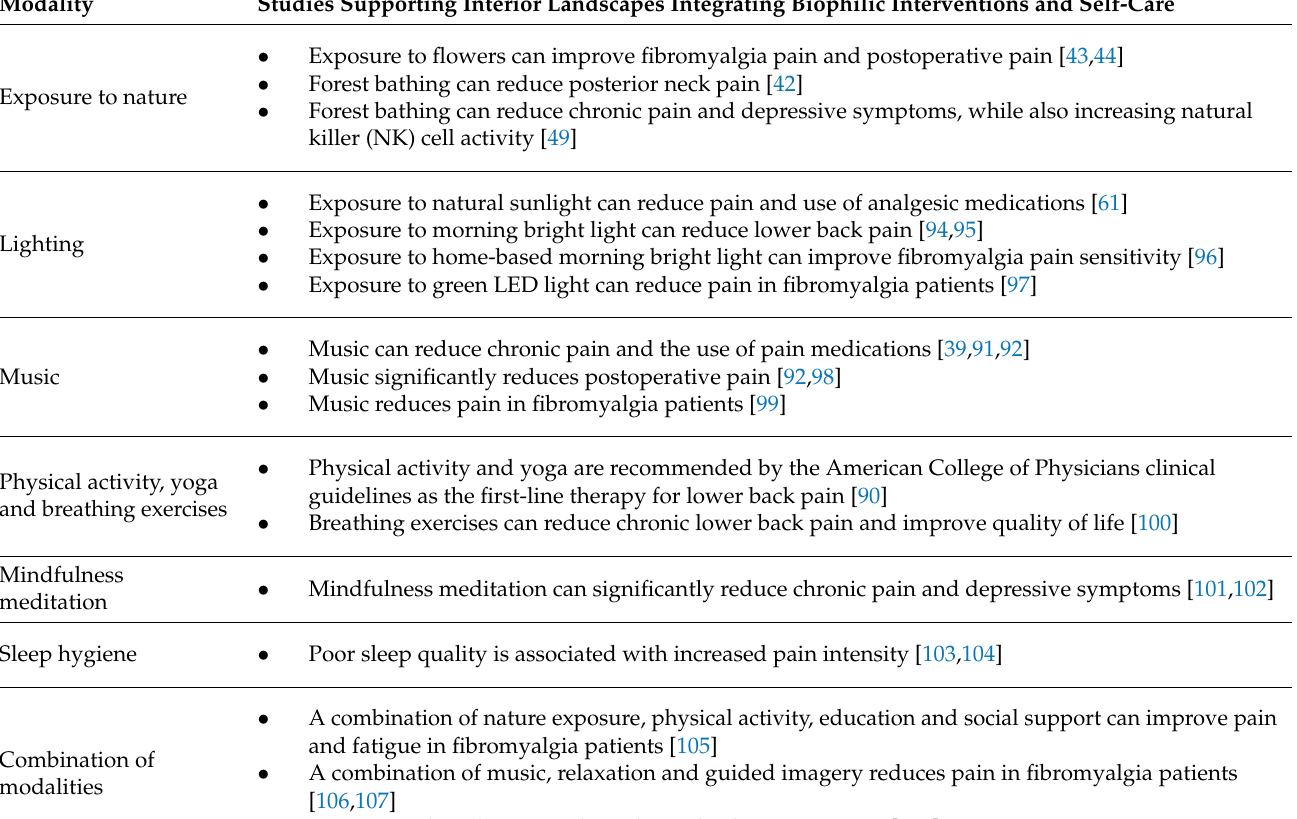
Table 2. Clinical evidence on incorporating nature exposure and self-care modalities into therapeutic interior environments for people with chronic